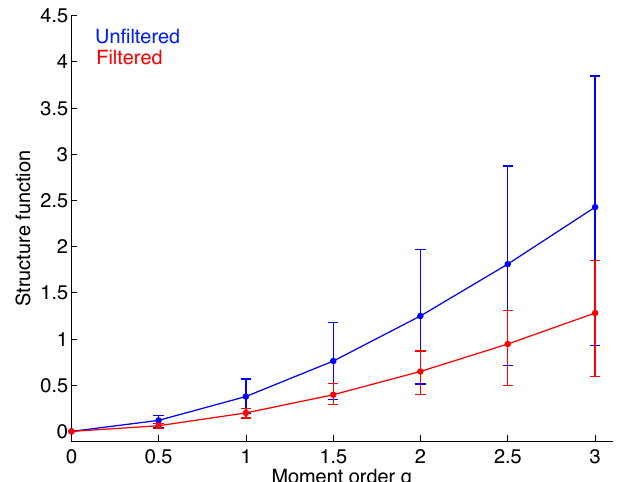
Figure 12. Structure function β(q) corresponding to the exponents of the power-law relationship between the absolute divergence rate and the spatial scale: (cid:104)|˙ (cid:15) div | q (cid:105) ∼ L − β(q) . The bars on the graph indicate the deviation from the power law as they correspond to the minimum and maximum power-law exponents obtained for two successive spatial